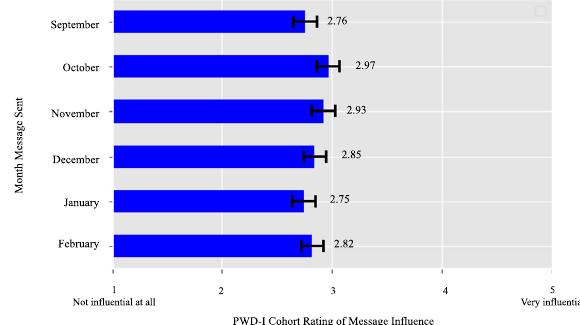
Fig. 5 Level of in fl uence from messages on getting the in fl uenza vaccine. Depicts the ratings provided by the PWD-I: People with diabetes-intervention group regarding how in fl uential each mes- sage was on their decision to get the in fl uenza vaccine. Ratings include standard error and were not statistically signi fi cantly different between interventions.